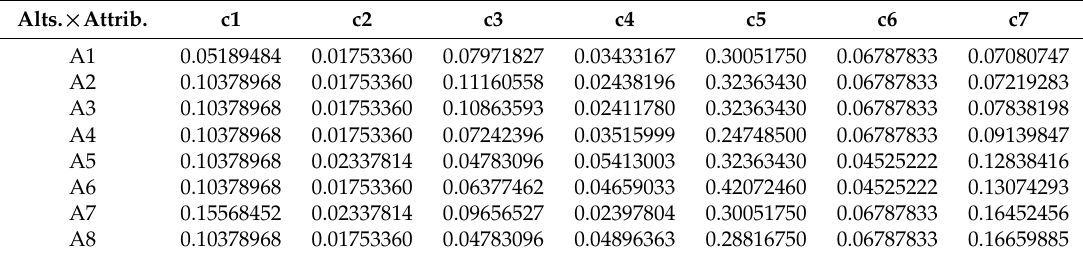
Table 4. The weighted normalized decision matrix (matrix WiNDMa